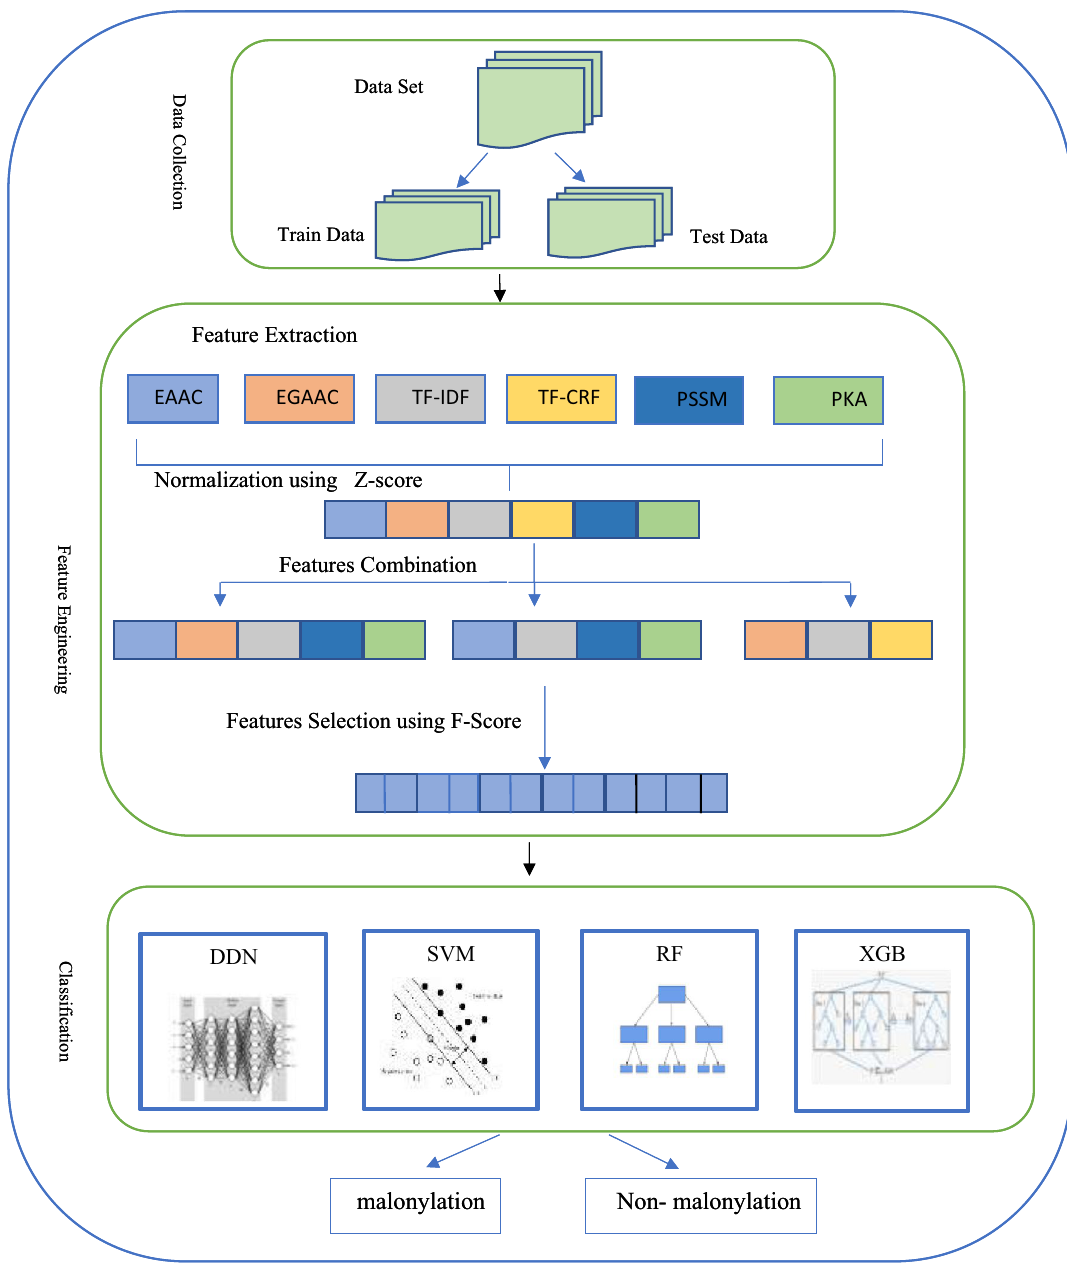
Figure 2. The overall block diagram of the proposed